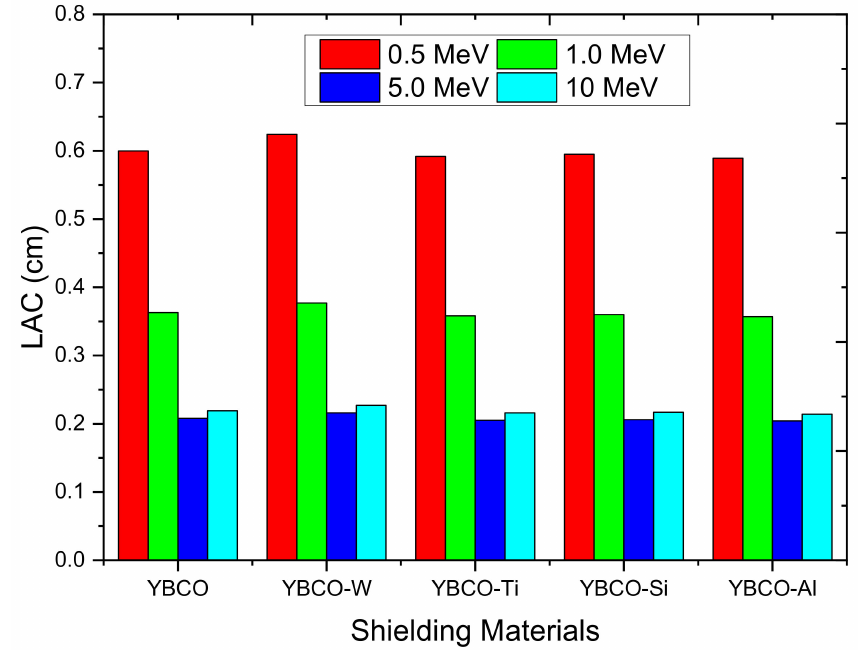
Figure 7. LAC values for the produced ceramics at 0.5, 1, 5, and 10 MeV.